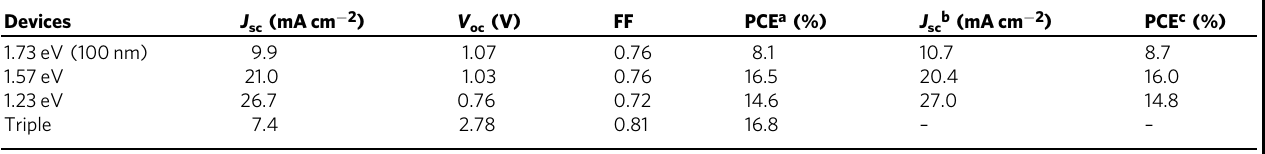
Table 3 Photovoltaic parameters of the single-junction and triple-junction PSCs.